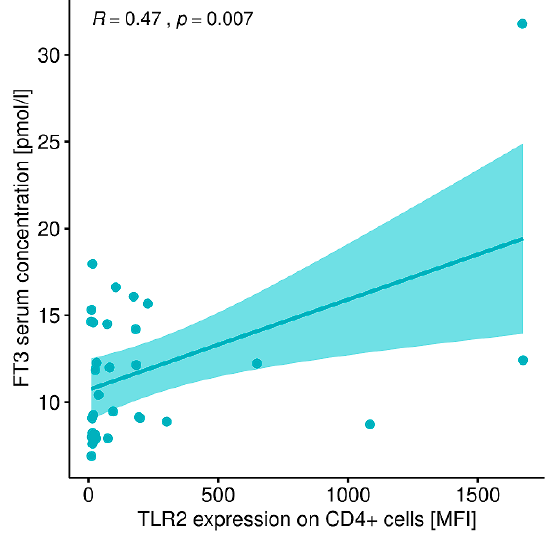
Figure 15. Correlation between TLR-2 expression level on CD4+ T lymphocytes (MFI) and FT3 (pmol/L) concentration in patients with GD before treatment. MFI, mean fluorescence intensity.